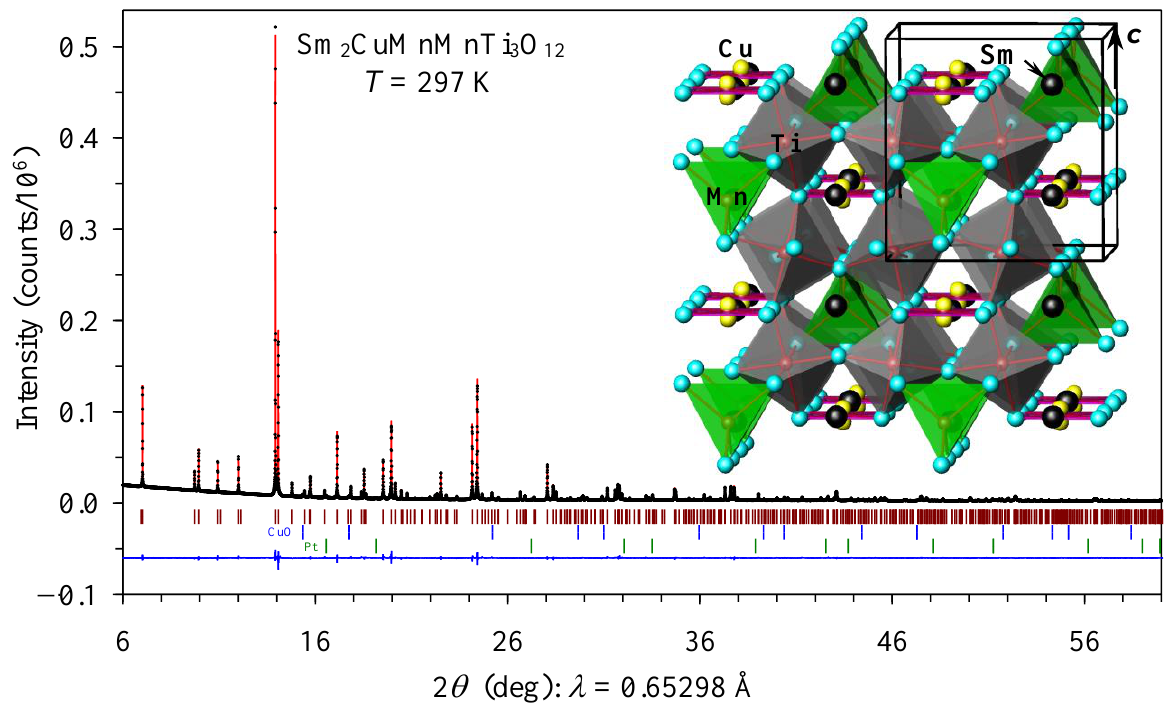
Figure 3. Full experimental (black crosses), calculated (red line), and difference (blue line at the bottom) room-temperature synchrotron powder X-ray diffraction patterns of Sm 2 CuMn(MnTi 3 )O 12 in a 2 θ range of 6 ◦ and 60 ◦ . The brown tick marks show possible Bragg reflection positions for the main phase, the blue tick marks are for CuO impurity (2.0 wt.%), and the green ones are for Pt impurity (0.3 wt.%). The inset shows a tetragonal crystal structure of Sm 2 CuMn(MnTi 3 )O 12 ; TiO 6 octahedra (gray), MnO 4 tetrahedra (green), and ideal CuO 4 square-planar units (red) are plotted; Sm atoms are given by black circles; split Cu sites are shown by yellow circles. Table 1. Structure parameters of Sm 2 CuMn(MnTi 3 )O 12 from synchrotron powder diffraction data ( λ = 0.65298 Å ) at room temperature.